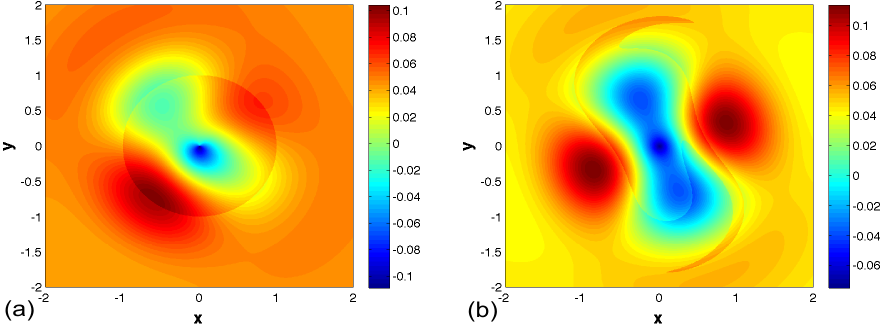
Figure 11. Evolution of the scaled lower boundary h . (a) The function h/D at time t = 0; (b) evolution of h/D at time t = 2.